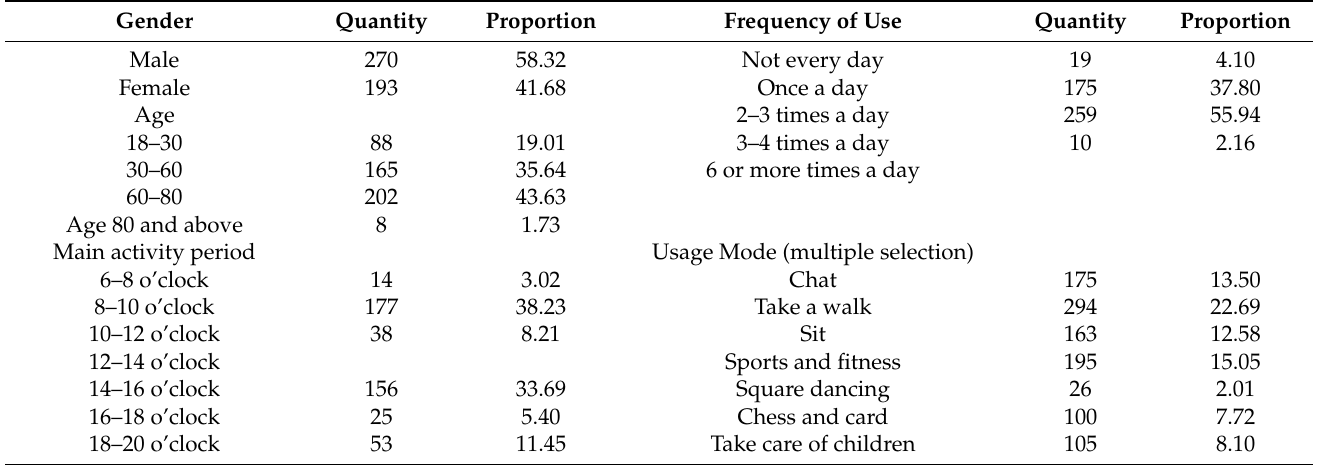
Figure 2. Locations of three affordable housing sample. Table 1. Investigation on the attributes of sample population and the characteristics of use behavior of internal and external public space.